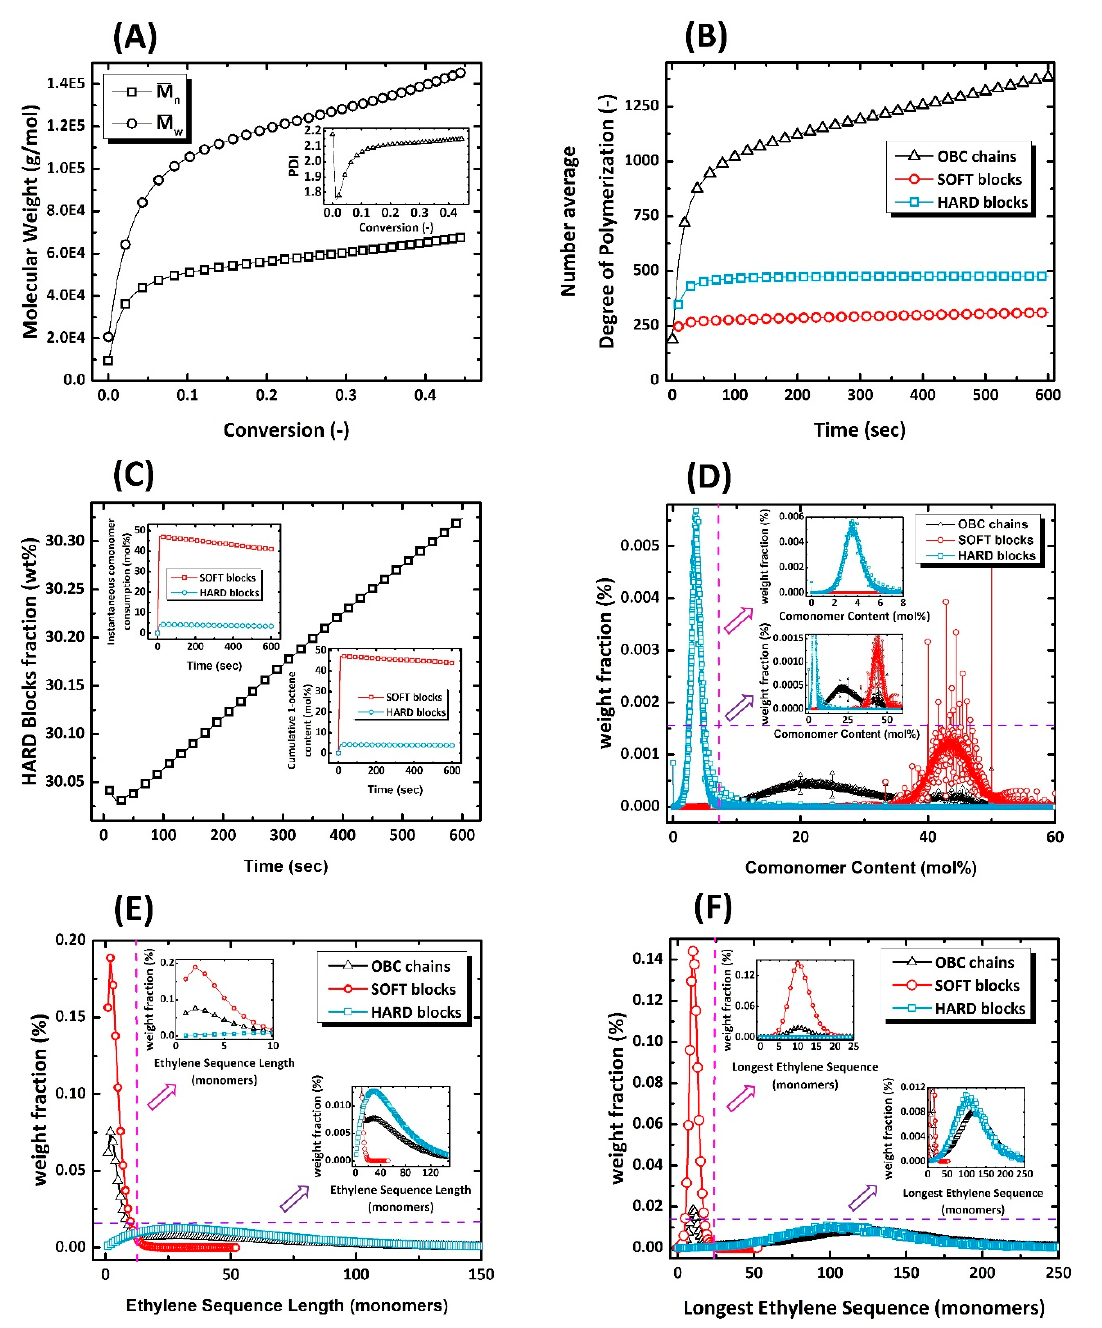
Figure 3. The identification card of intelligently synthesized OBC1 demonstrating all instantaneous and cumulative microstructural features of virtually produced chains.